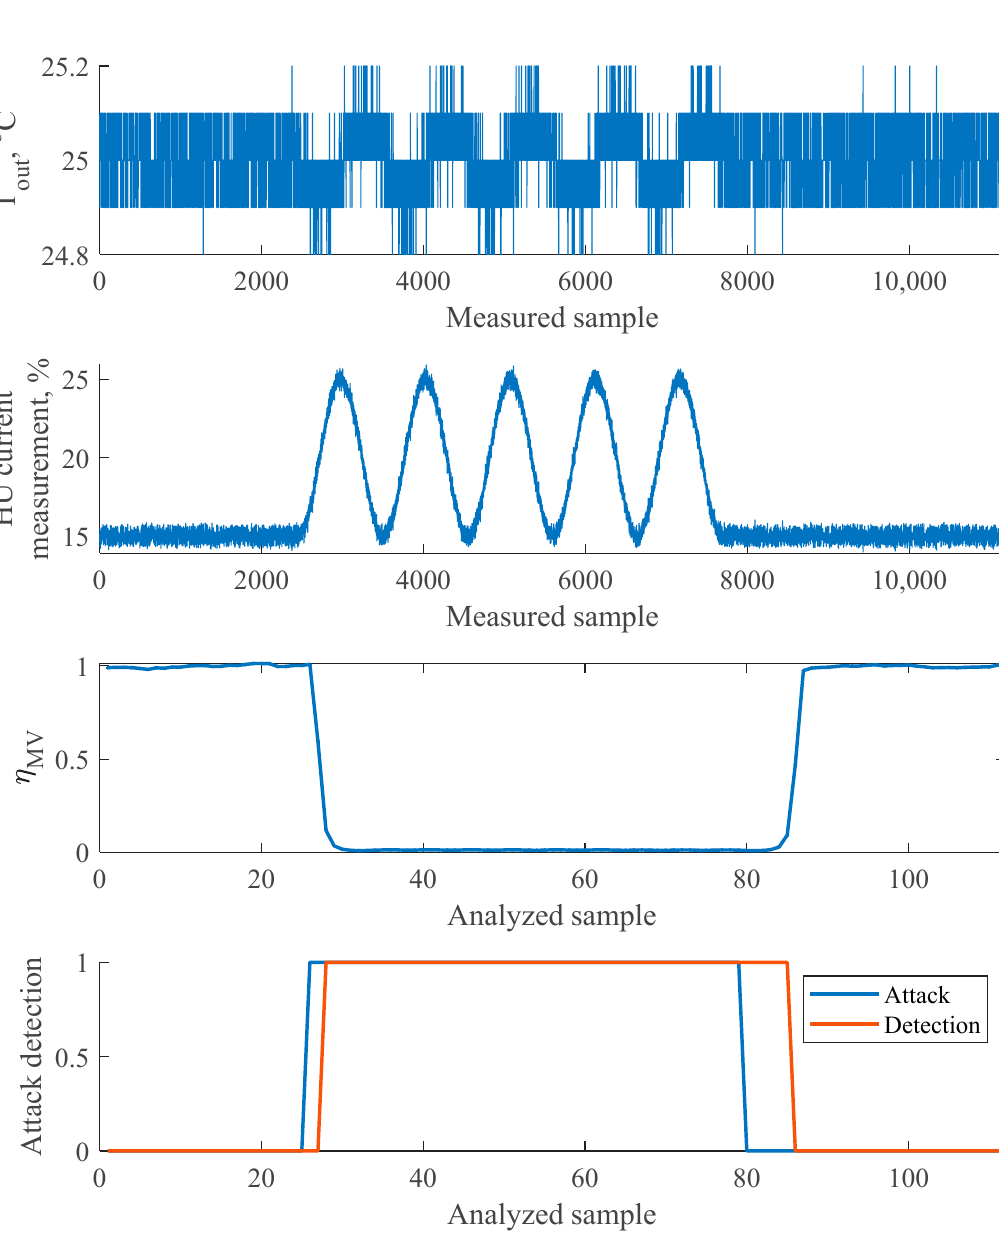
Figure 7. Effect of the sinusoidal attack signal on process control.